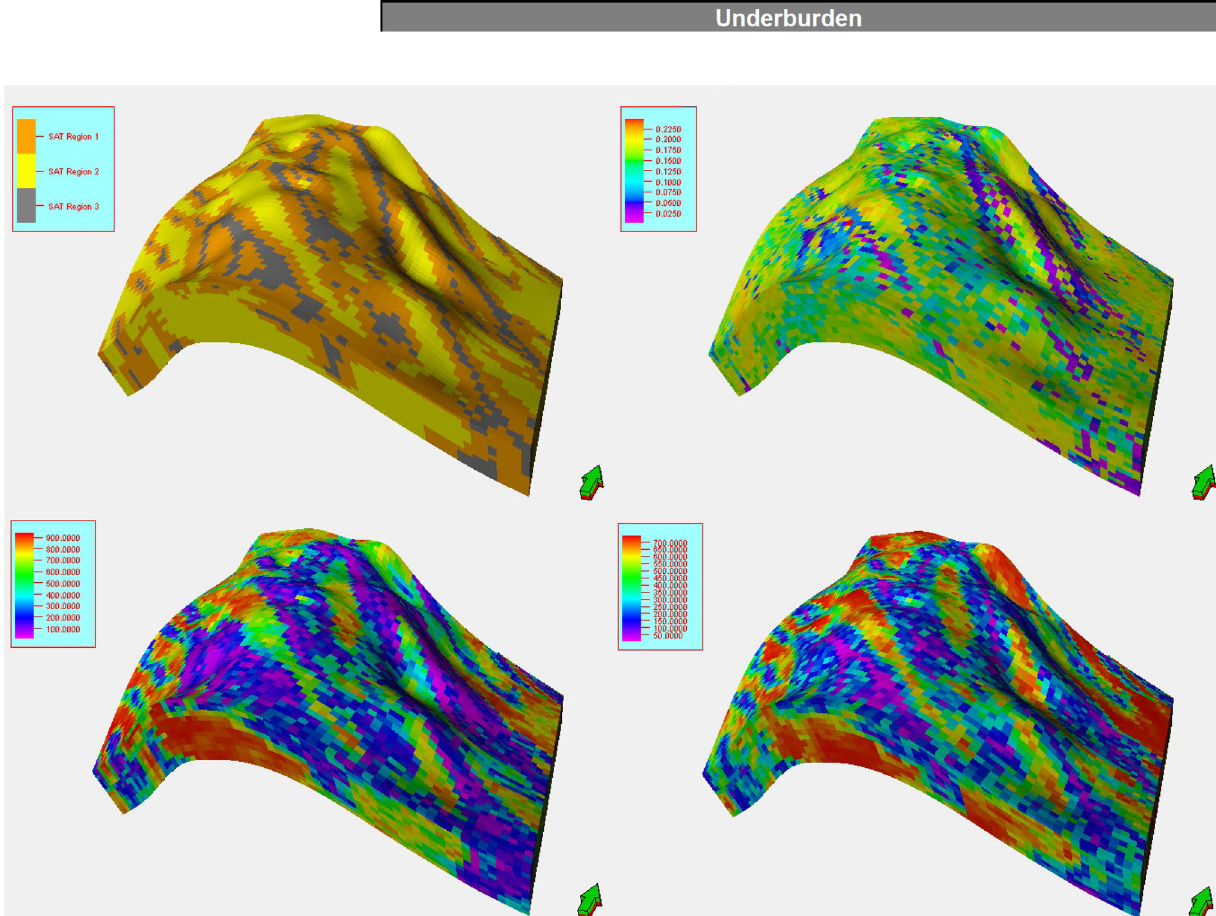
Fig. 3 3D lithofacies and petrophysical property models of the main pay/South Rumaila oil